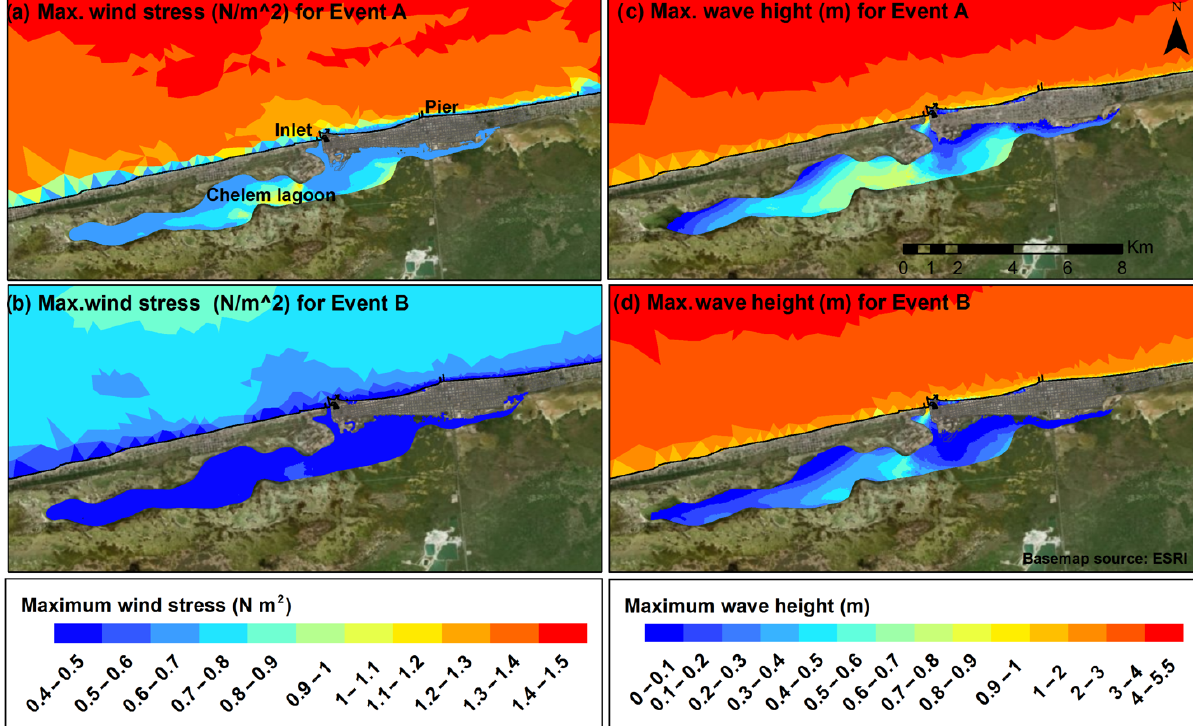
Figure 8. Highest wind stress values during Event A (a) and Event B (b) , and highest wave height values for Event A (c) and Event B (d) .